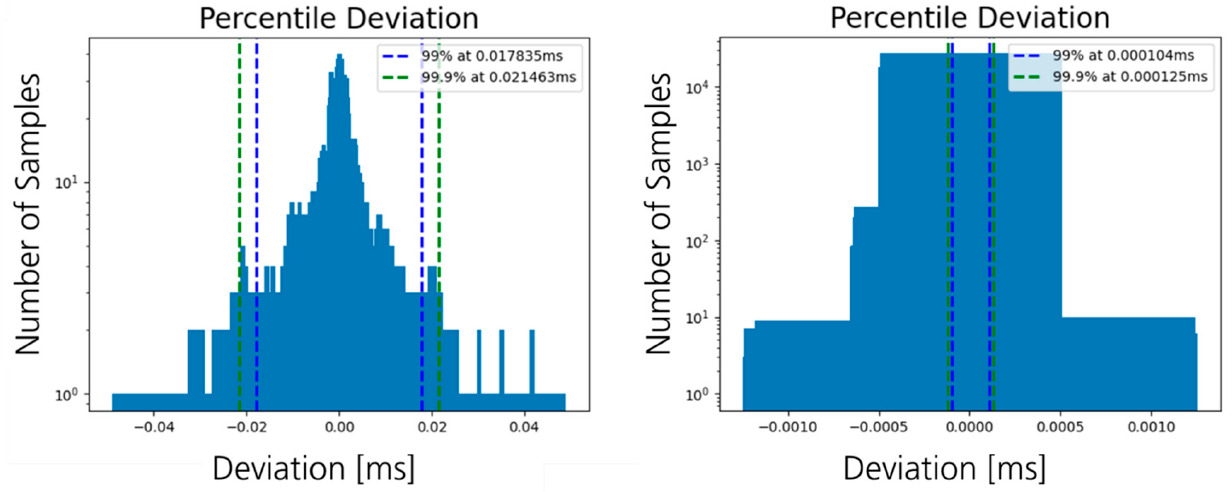
Figure 12. Left: Jitter of the PC output at the network card of the PC. Right: Jitter of the shaped PC output at the egress gate of TSN-Switch 1.